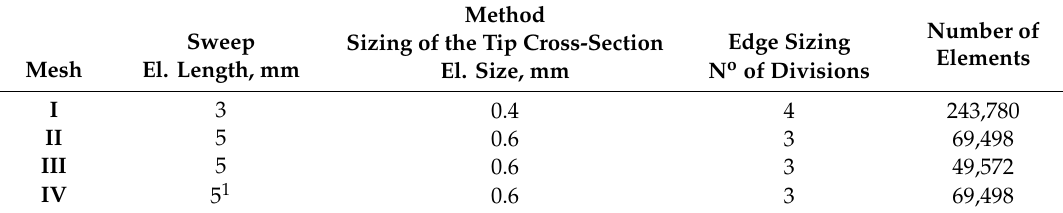
Figure 10. Comparison of blade grids in cross ‐ sections in meshes ( a ) II, III, IV, and ( b ) I.